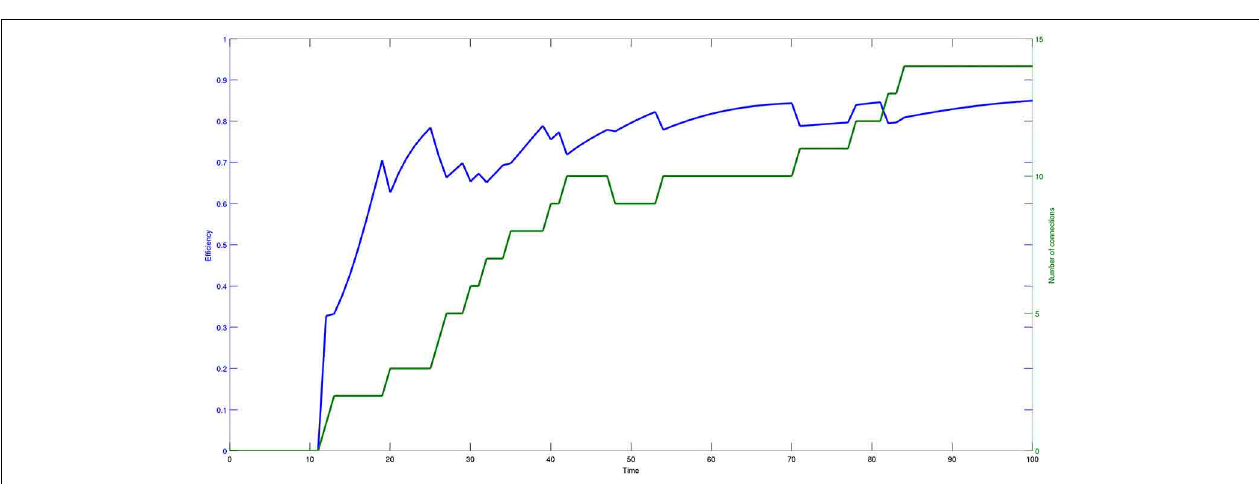
received initially is null for all bacteria. The presence of oscillating behaviors, such as the one shown by bacterium 1, shows that the final configuration is also the result of transient activated/deactivated connections.